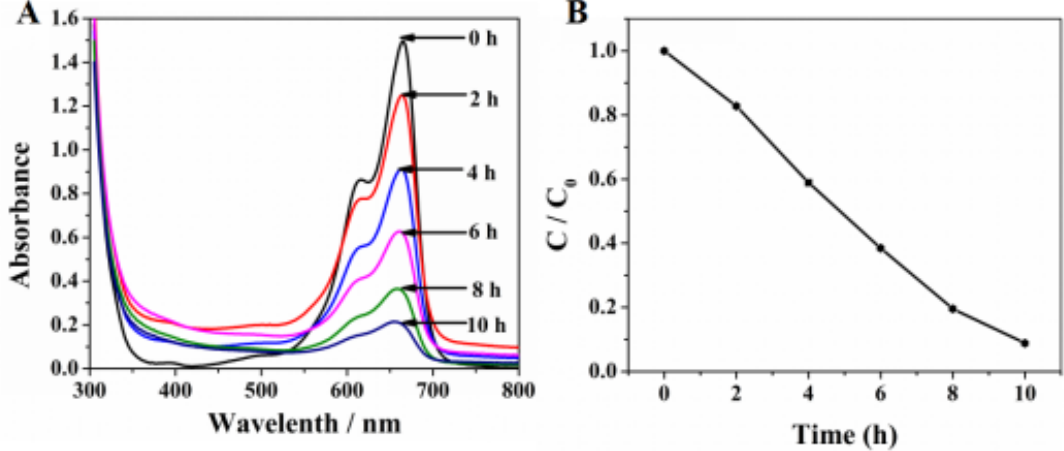
Figure 11. ( A ) UV-vis spectra obtained during the MB oxidative degradation over CF300; and ( B ) the MB degradation rate at various reaction time.